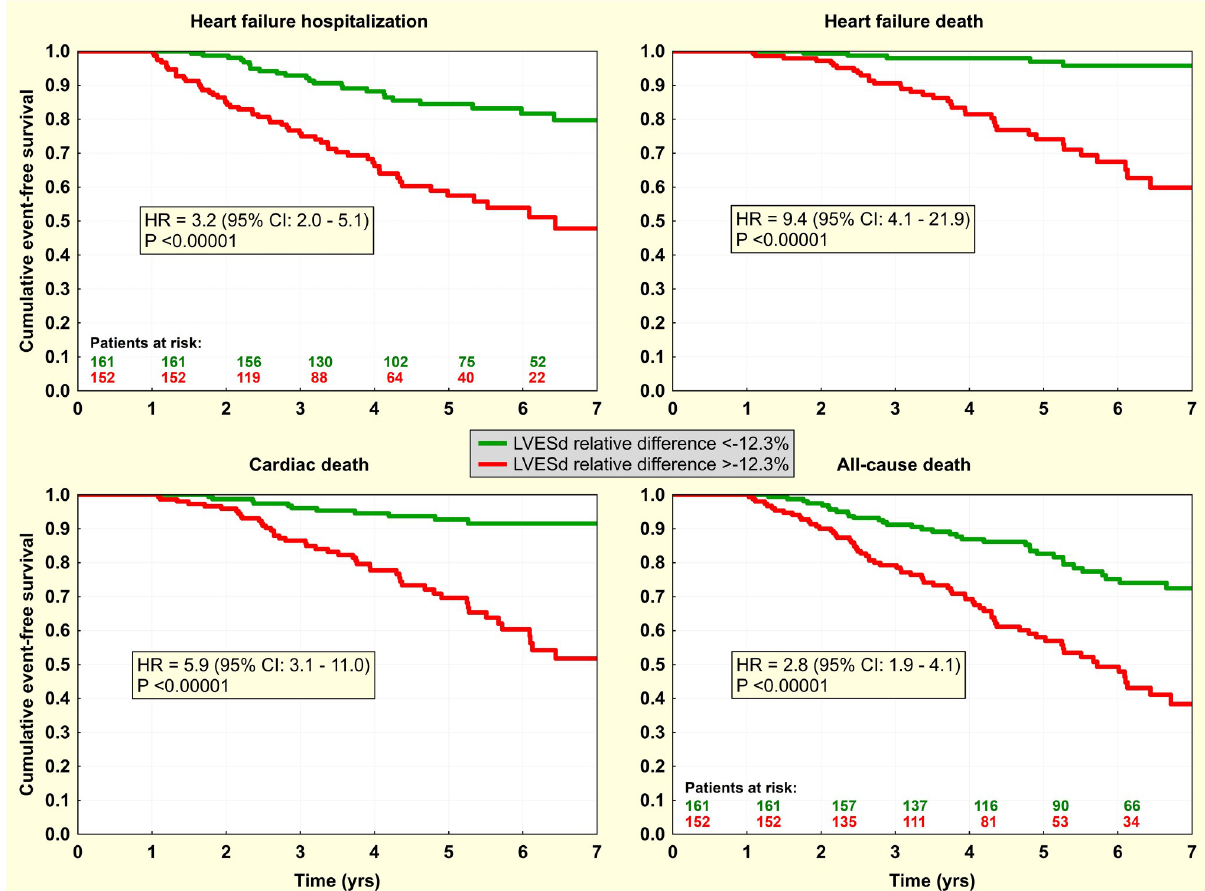
Fig 2. Event-free survival according to post-CRT reverse left ventricular remodeling. Kaplan-Meier curves for the first heart failure hospitalization / death and cardiac / all-cause death according to relative change in left ventricle end-systolic diameter (LVESd) with dichotomy of -12.3% relative